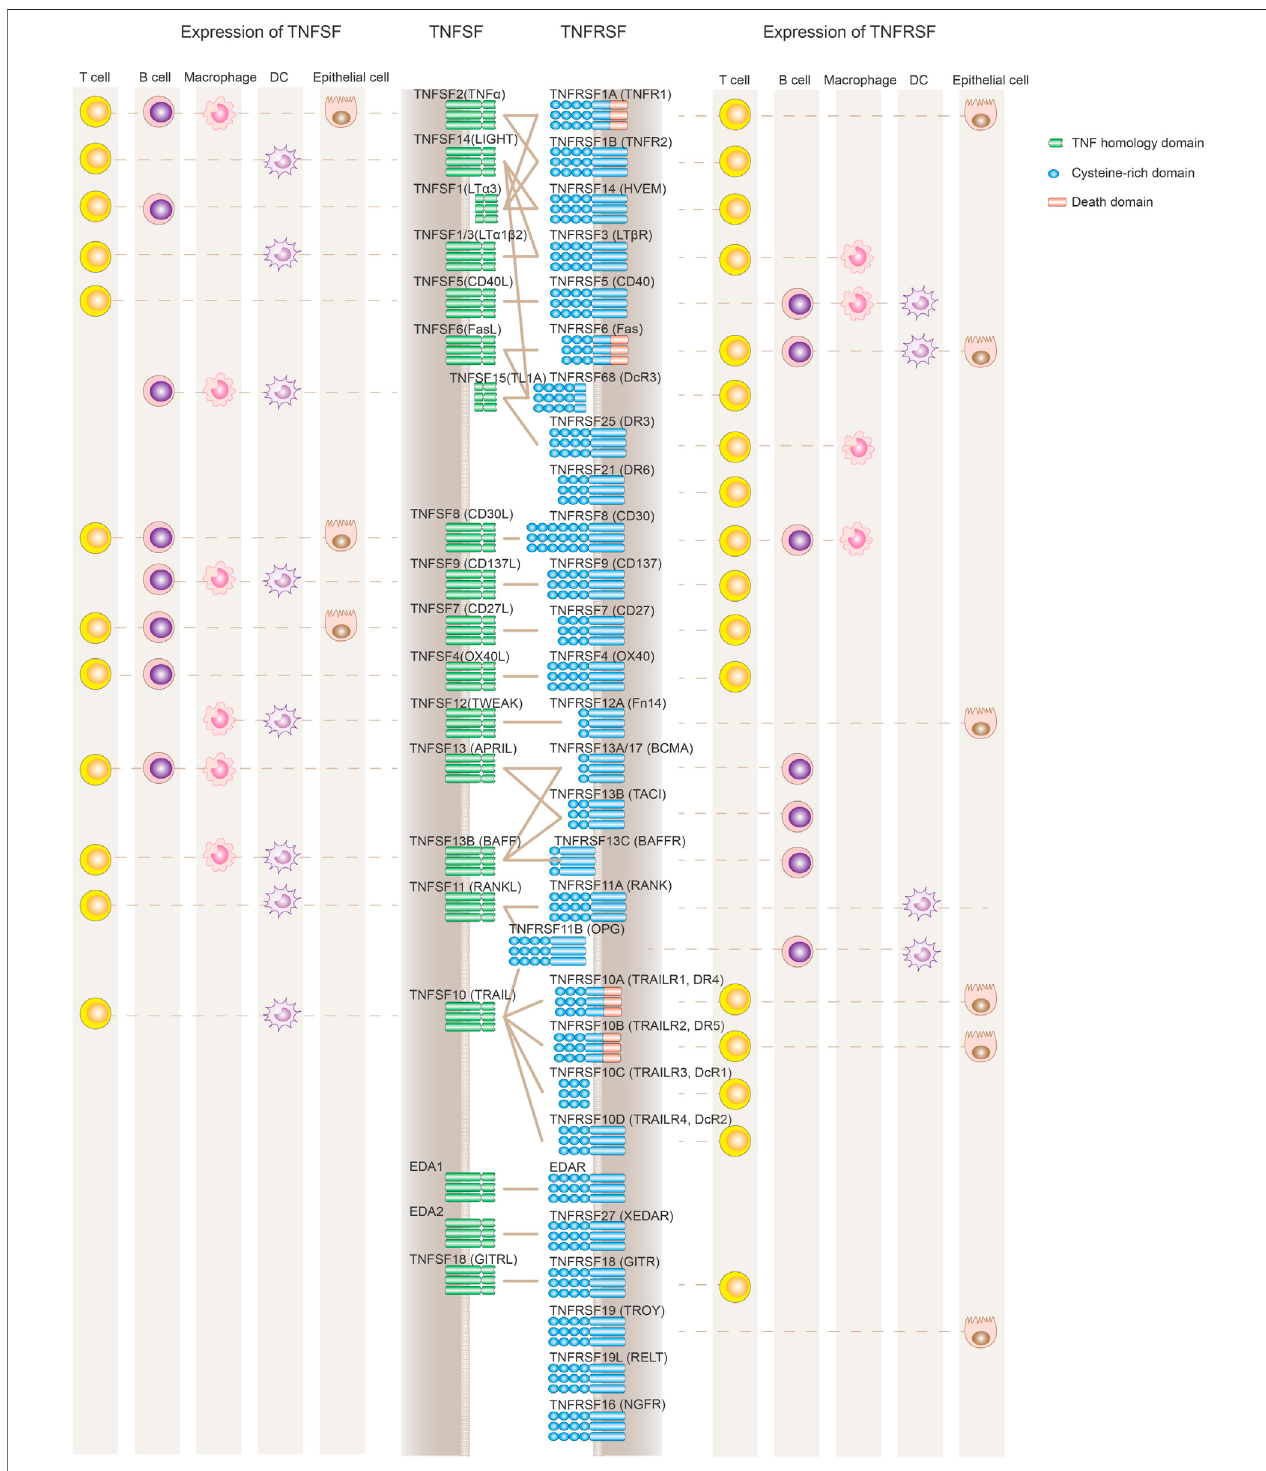
FIGURE 1 | Expression and interaction of TNFSF and TNFRSF members. TNFRSF members (depicted in blue on the right) contain variable numbers of cysteine- richdomains(CRD)intheirligand-bindingextracellularregions.TNFSFligands(leftsideshowningreen)areactiveprimarilyasnon-covalentlyassociatedhomotrimersor homodimers to facilitate the formation of TNFRSF trimer clustering and its downstream signaling activation. TNFRSF members regulate the immune system mainly througheitherstimulatingcellproliferationandmaturationorpromotingapoptoticcelldeathviaadeathdomain.Alsodepictedaretheprimarycelltypesexpressing TNFRSFandTNFSF,althoughthelistisnotcomprehensivetorepresentthecomplexexpressionpro fi leofeachmolecule,andsomecellpopulationssuchasNKcellsor monocytes are not included. Both TNFSF and TNFRSF members are widely and dynamically expressed in different immune cell populations.